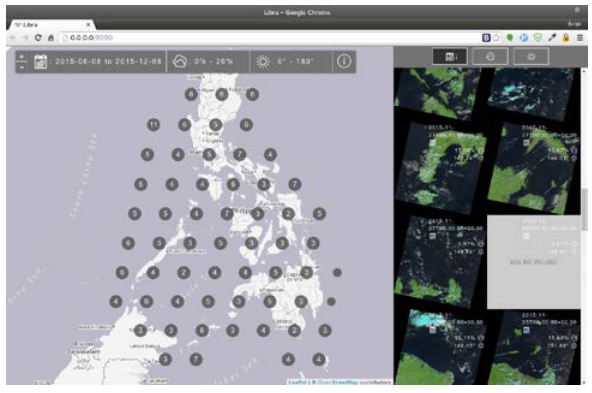
Figure 3 Screenshot of